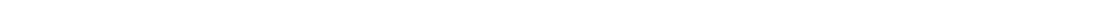
Fig. 5 NSC-370284 and UC-514321 function as TET1 -transcription inhibitors in TET1 -high AMLs and their anti-leukemic effects are TET1-dependent. a NSC- 370284 and UC-514321 inhibit the transcription of TET1 , but not TET2 or TET3 . MONOMAC-6 cells were treated with DMSO control, 500 nM NSC- 370284 or UC-514321 for 48 h. Gene expression levels are shown. b Effects of NSC-370284 and UC-514321 in downstream gene targets of TET1. c NSC- 370284 and UC-514321 repressed global 5hmC level in MONOMAC-6 cells. d The association between STAT3 and UC-514321 as determined with NMR CSPs (red peaks: free STAT3; green peaks: STAT3-UC-514321 complex). e – h MONOMAC-6 cells were treated with DMSO control, 500 nM NSC-370284 or UC-514321. ChIP-qPCR assay was carried out 48 h after drug treatment. Enrichment of STAT3, STAT5, or IgG at the TET1 promoter region and other regions are shown. i – l Functions of NSC-370284 and UC-514321 depend on Tet1 expression. BM progenitor cells of wild-type or Tet1 − / − mice were retrovirally transduced with MLL-AF9 . Infected cells were treated with NSC-370284, UC-514321, and other JAK/STAT pathway inhibitors, i.e., Pacritinib, KW-2449, Stattic and sc-355979, at indicated doses ( i , j ), or at a particular dose (i.e., 500 nM); k , l for 48 h. Relative cell viabilities are shown. m Cre- Tet1 fl / fl mouse BM progenitor cells were retrovirally transduced with MLL-AF9 . Transduced cells were induced with polyI:C for 7 days, and then treated